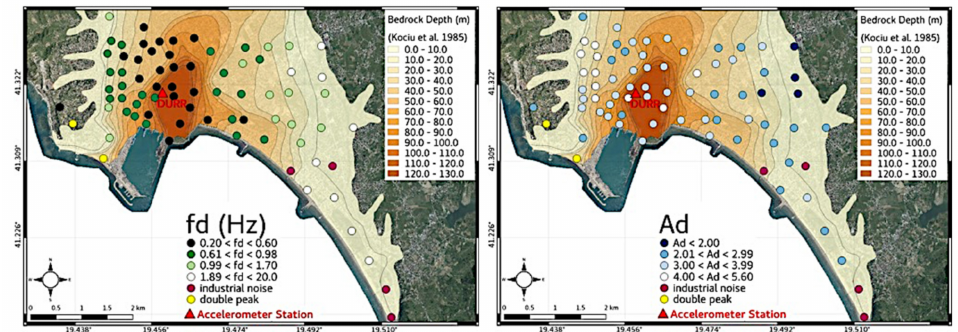
Figure 13. Distribution of the dominant frequency, f d , in the city of Durres ( left ); distribution of the corresponding to the dominant frequency, A d amplitude ( right ). Bedrock depth iso-contours by